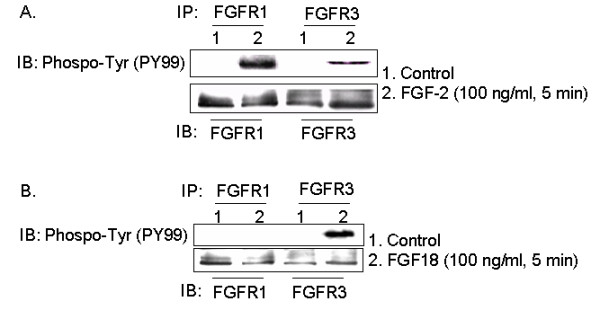
Activation of FGFR1 and FGFR3 by FGF-2. (A) Human articular chondrocytes in monolayer were stimulated with FGF-2 (100 ng/mL) for five minutes before whole cell lysates were prepared. The lysates were incubated with antibody against FGFR1 or FGFR3 in separate tubes. Equal amounts of total protein after immunoprecipitation (IP) were resolved on SDS-PAGE gel, followed by immunoblotting of phospho-tyrosine. Antibody against total FGFR1 or FGFR3 was used to evaluate loading precision. (B) Human articular chondrocytes in monolayer were stimulated with FGF18 (100 ng/mL) for five minutes before whole cell lysates were prepared. The following steps were performed as described above. FGF, fibroblast growth factor; FGFR, FGF receptor.